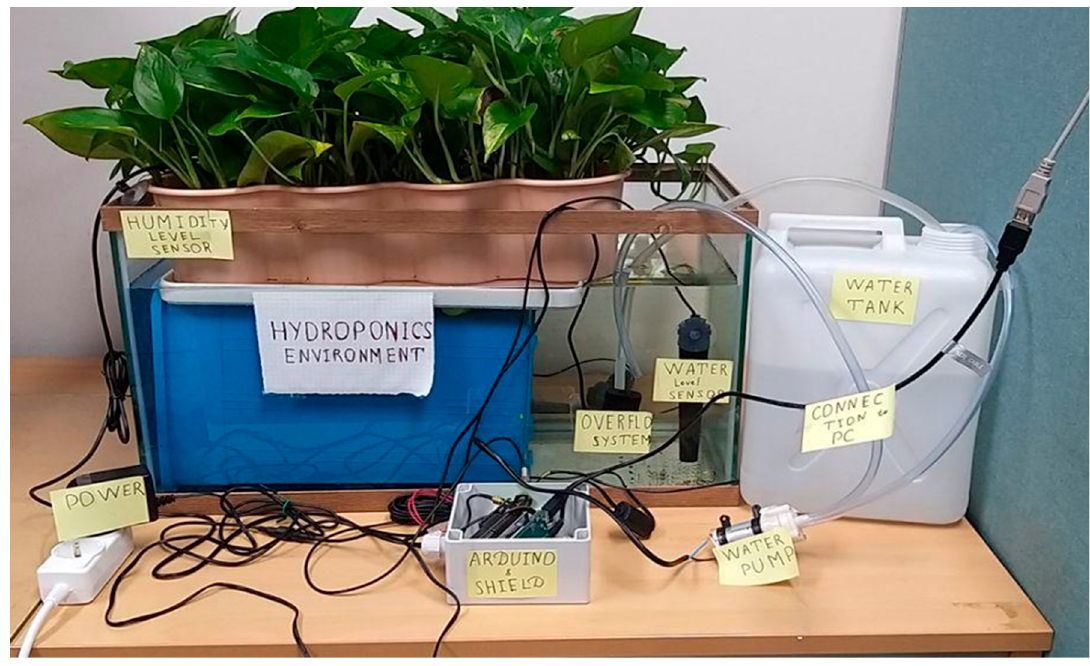
Figure 11. Hydroponics experimental environment.